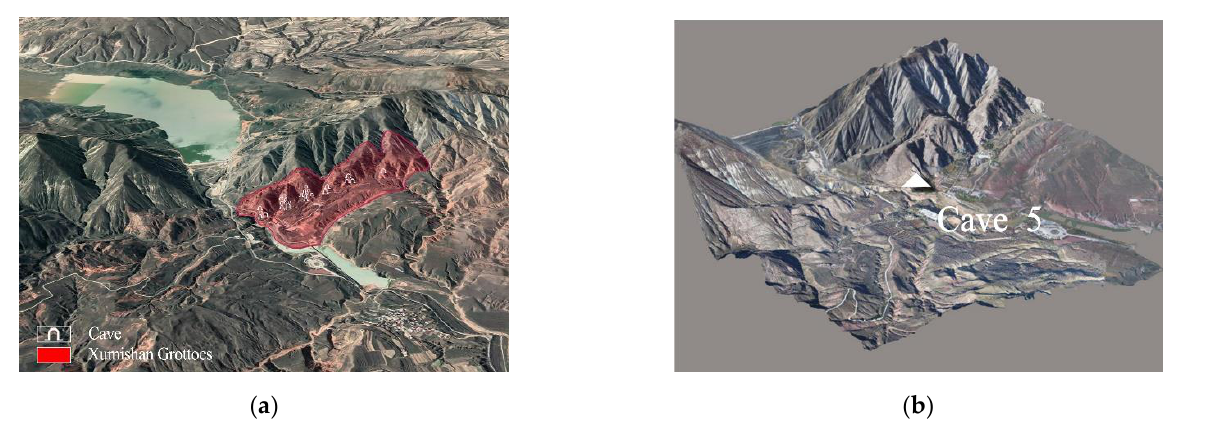
Figure 7. ( a ) Perspective view from the east, where red is the Grotto Zone, ( b ) topography map of the focused terrain.